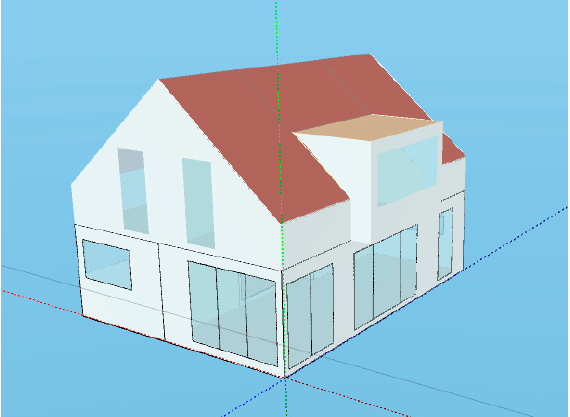
Table 2. Basic geometric data.